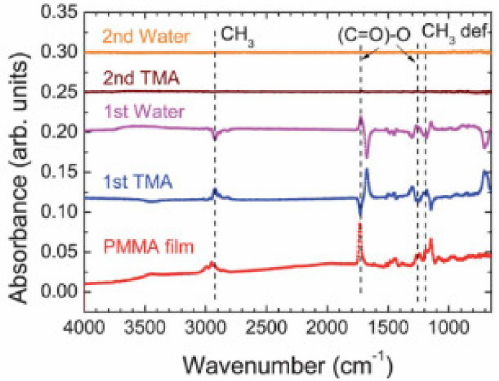
Figure 6. In-situ FTIR analysis of uncoated PMMA spin-coated onto Si, first, and second ALD half-reactions. Al 2 O 3 coating was made from TMA and H 2 O at 80 ◦ C. A FTIR run followed each half-cycle, and between half-cycles, the reactor was purged for 10 s (republished with permission of Be Gong, from [52]; permission conveyed through Copyright Clearance Center,